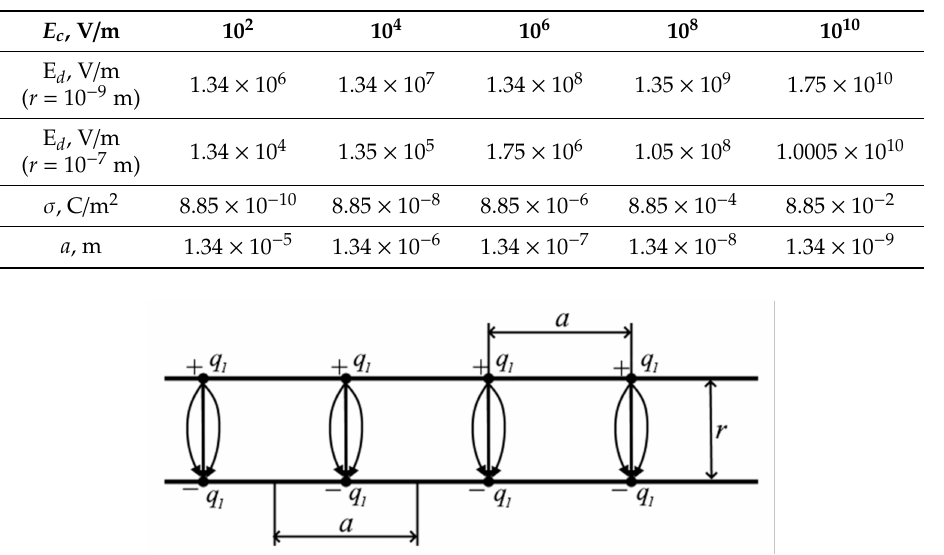
Table 2. Strengths of electric fields E c and E d for the case of a nanometer-sized gap ( r = 10 − 9 m) in vacuum ( ε = 1). An electric field is created by applying an electric voltage to the interelectrode gap. Additionally, the corresponding values of the density of surface charges σ , and the distances a between discrete charges are given.